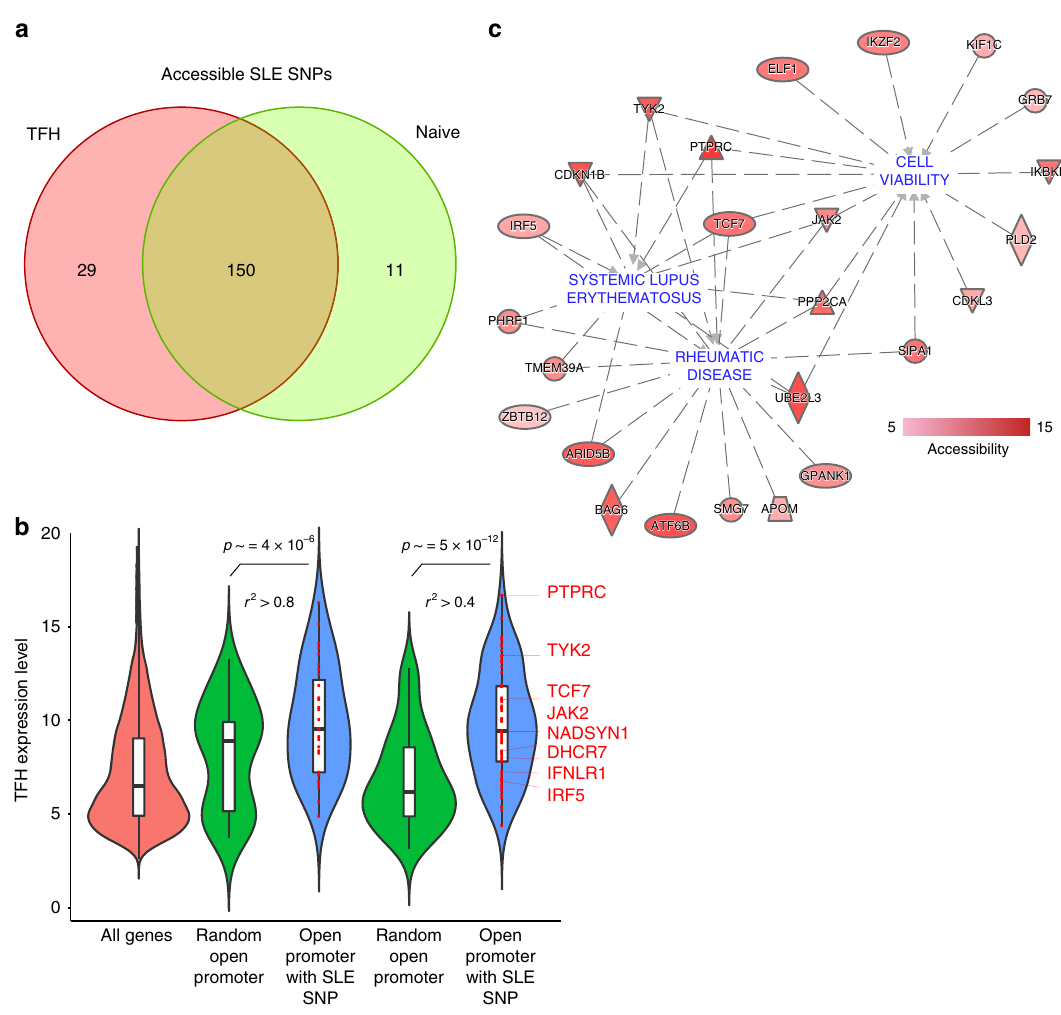
Fig. 2 Genes harboring accessible SLE variants in naive and follicular helper T cells. a Comparison of accessible SLE SNPs between TFH and naive tonsillar T cells. b Comparison of the expression levels of genes with accessible SLE SNPs in their promoters in TFH vs. all genes or a random sample of genes with no accessible SLE SNPs in their promoters. A two-side Wilcoxon rank-sum test was performed to evaluate the signi fi cance of differential expression between gene sets. c Ingenuity disease network for the genes with accessible SLE variants at promoters. The color gradient represents the log2 fold change in accessibility in TFH compared to naive T